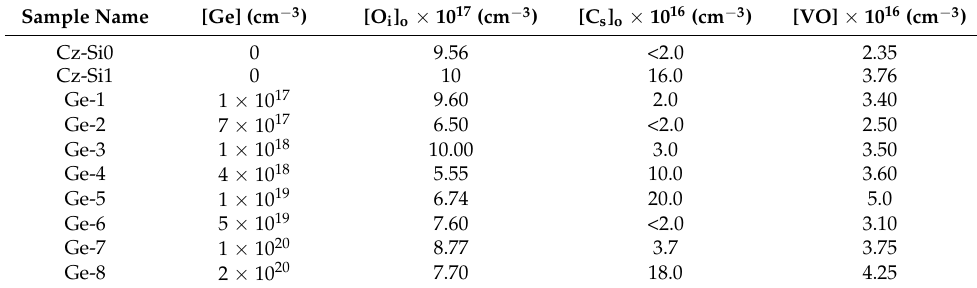
Table 3. The concentrations of Ge, O i and C s of the Cz–Si:Ge samples used in Figure 5